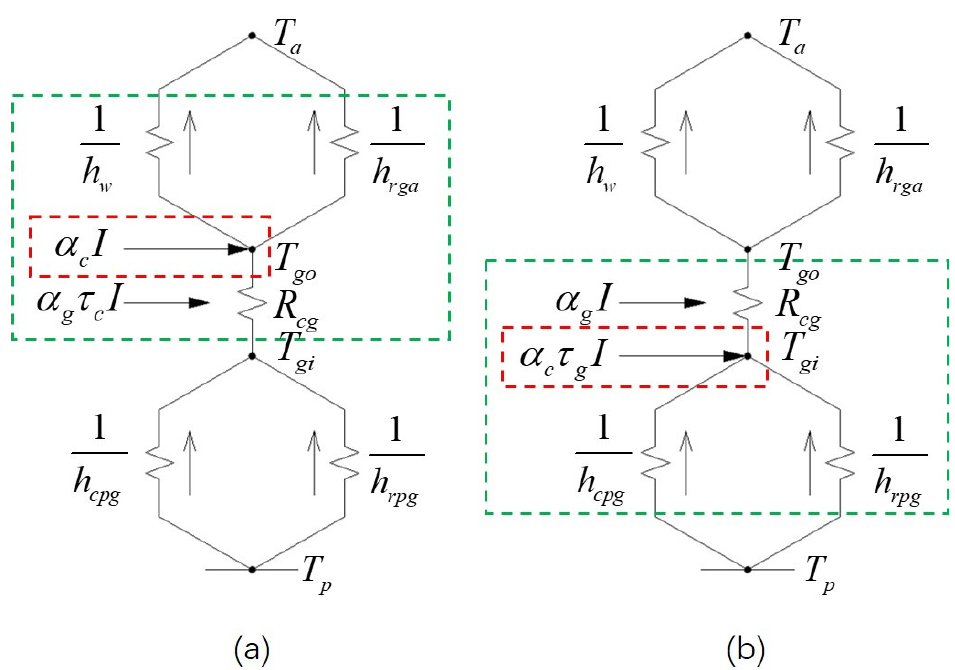
Figure 6. Thermal network for upward heat flow including solar energy absorbed by the coating and glass cover: ( a ) coating on the outer surface of the cover plate, ( b ) coating on the inner surface of the cover plate. The part in the red dotted box is the solar energy absorbed by the coating. The part in the green dotted box is the sketch of energy balance on the coated surface of the cover plate.